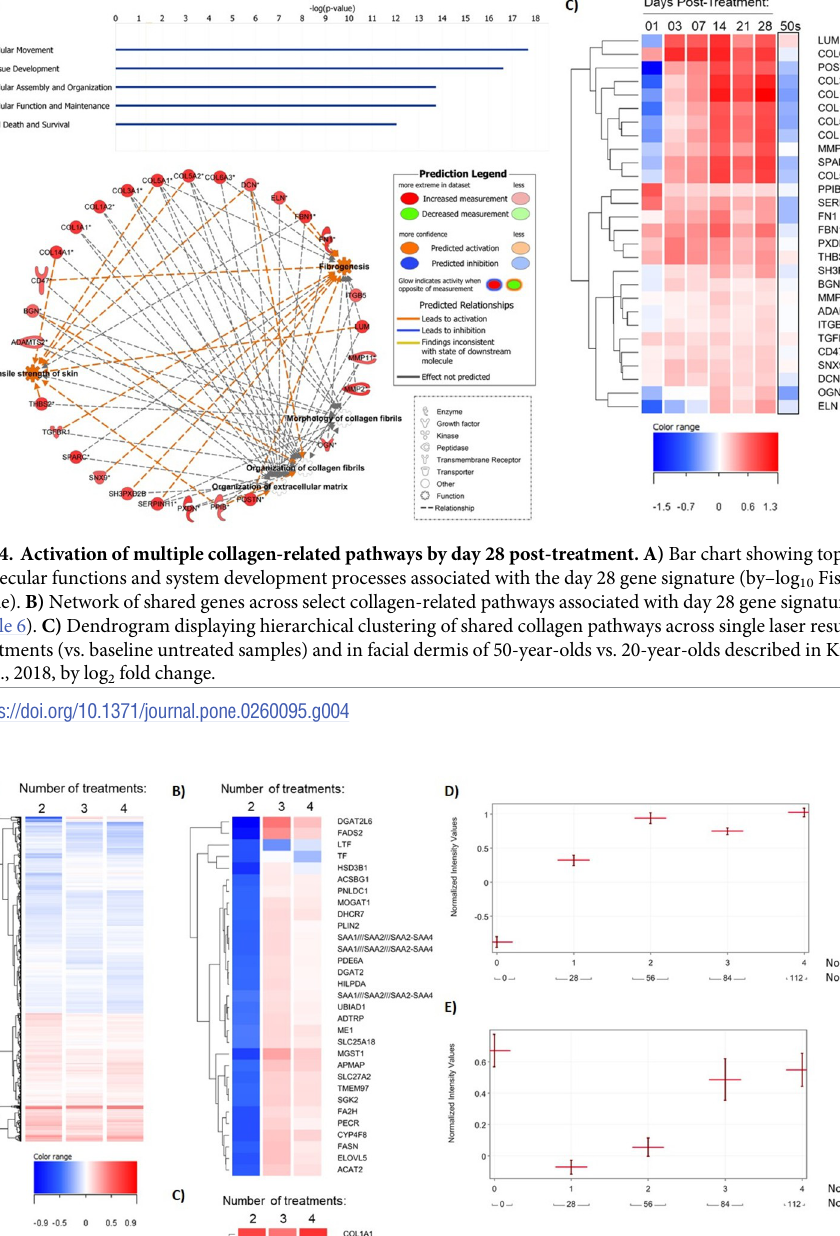
PLOS ONE | https://doi.org/10.1371/journal.pone.0260095 November29,